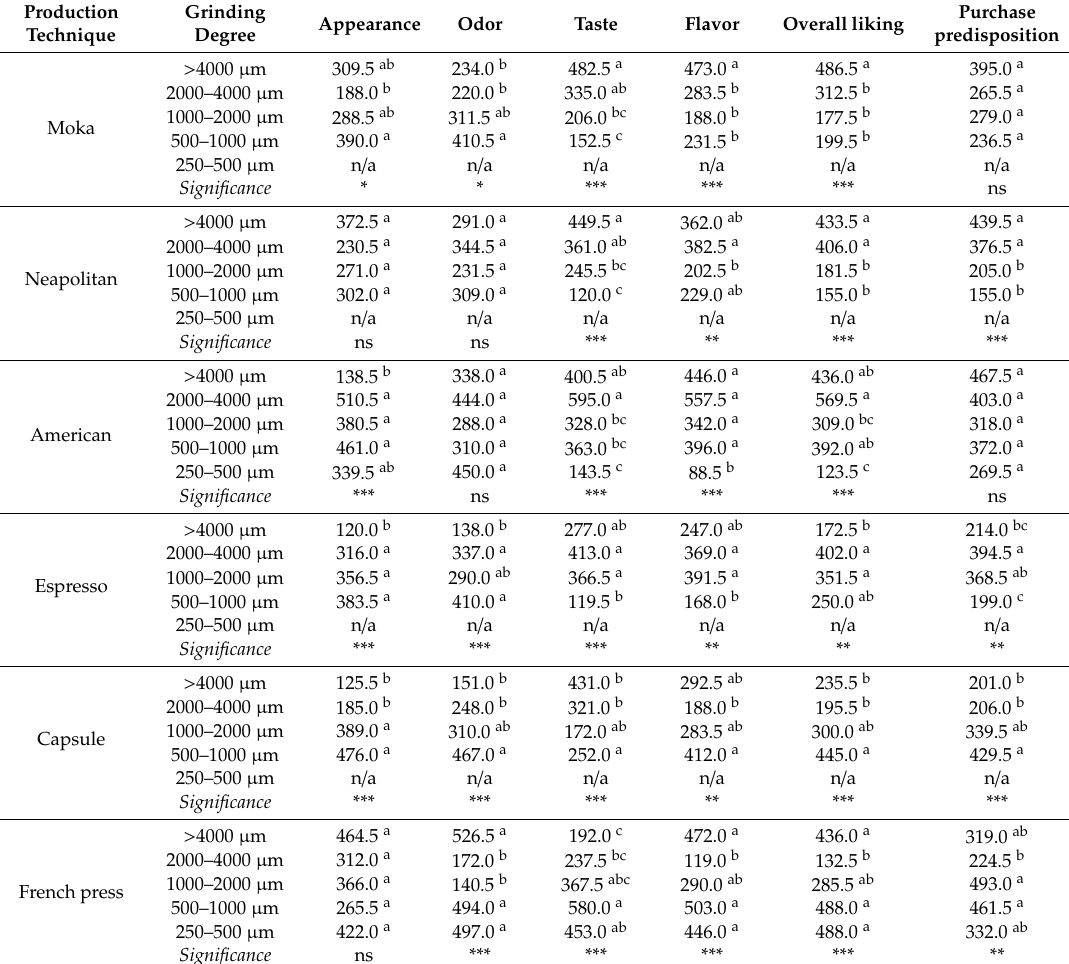
Table 4. Consumer evaluation of the beverages and results of the Kruskal–Wallis test. Data are expressed as the sum of ranks of the results obtained from 20 tasters who filled out a nine-point hedonic scale (1 = extremely dislike, 9 = extremely